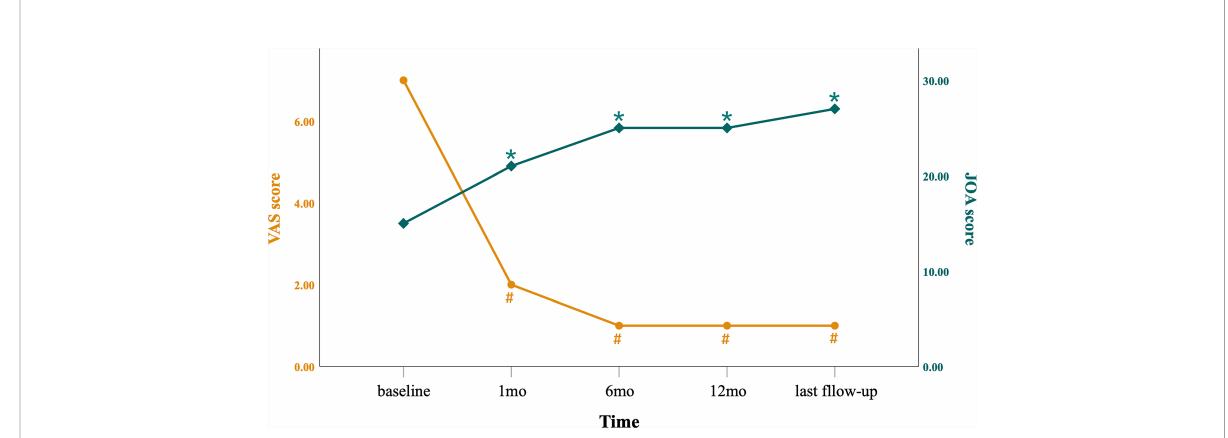
FIGURE 10 Preoperative and postoperative VAS and JOA scores. Over time, the VAS score decreased gradually and the JOA score increased gradually. #P <0.001 when comparing VAS scores with those of preoperative evaluation; *P <0.001 when comparing JOA scores with those of preoperative evaluation. mo, month.